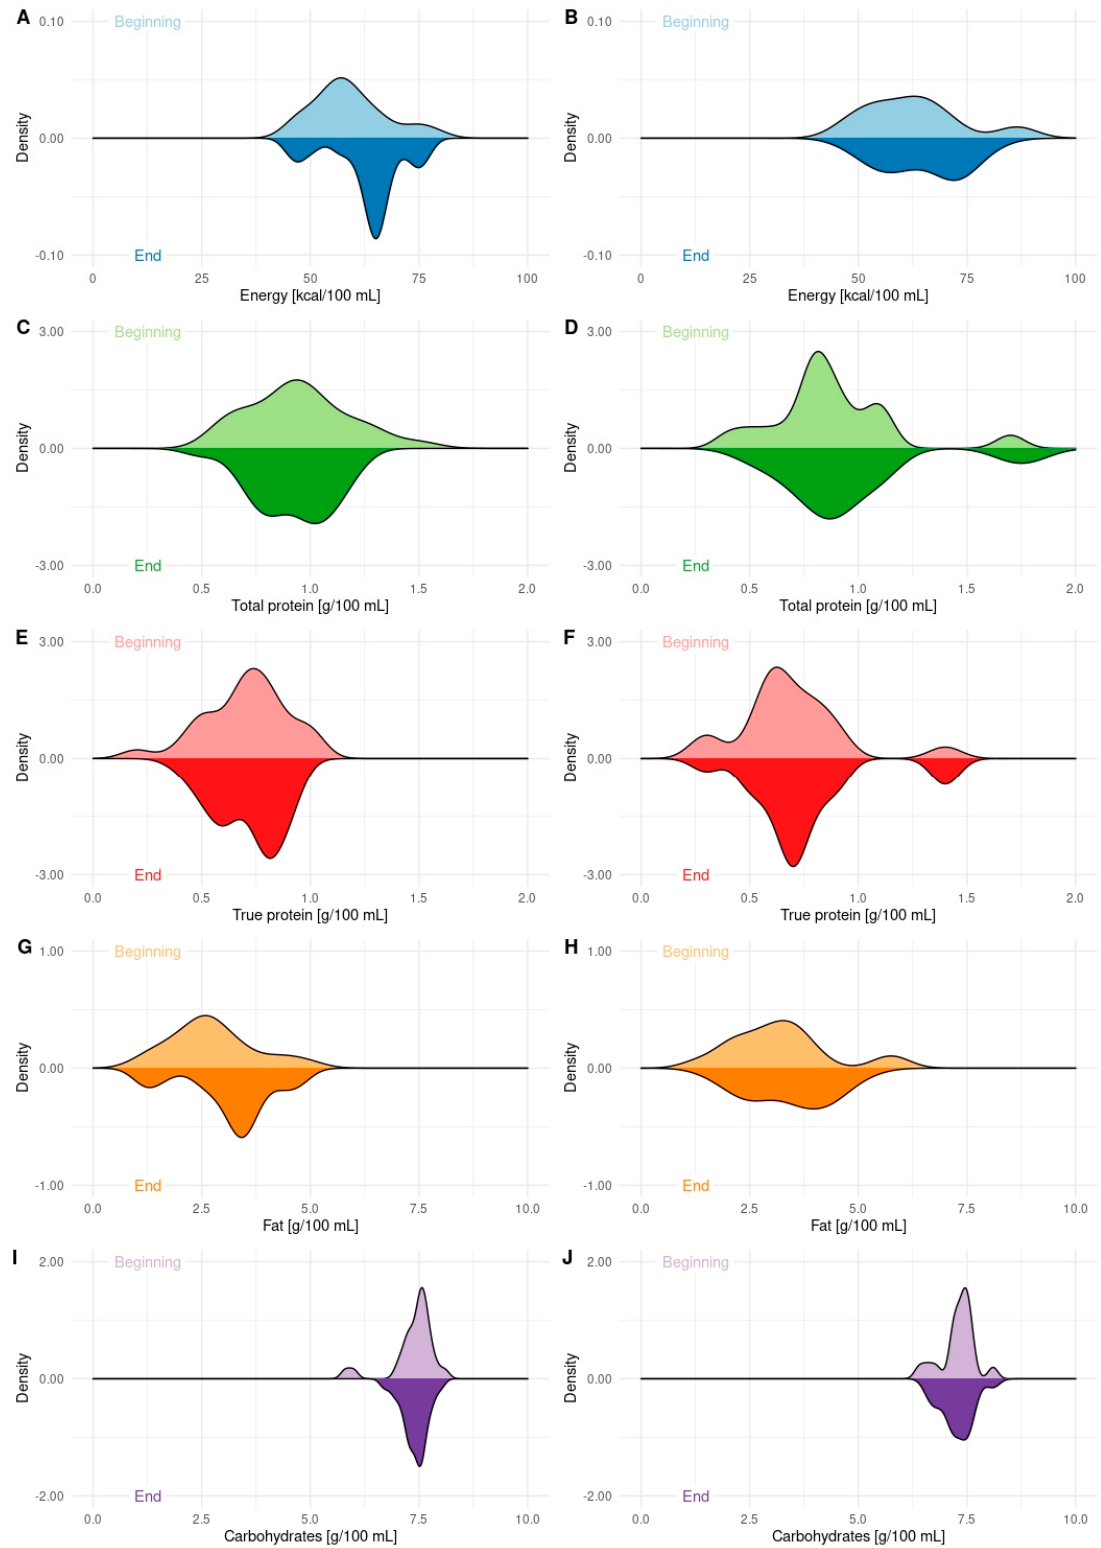
Figure 2. Density plots presenting energy and macronutrients contents of DHM at the beginning (upper part of each panel) and in the end (bottom part of each panel) of the milk donation ratio to HMB, according to the method of infant’s feeding. Panel ( A , C , E , G , I ) present the composition of DHM from mothers who exclusively breastfed their infants. Panel ( B , D , F , H , J ) present the composition of DHM from mothers who feed their infants only with expressed milk.